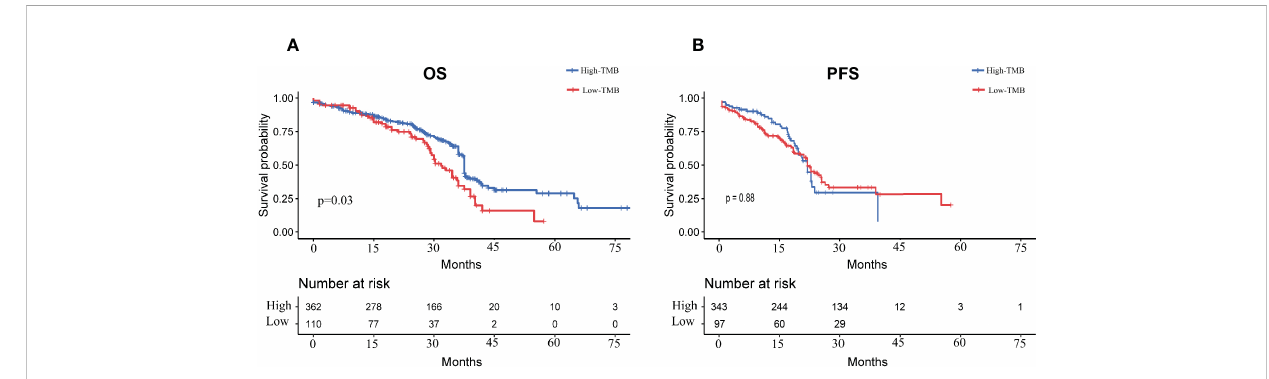
FIGURE 3 Survival curves of LUAD patients in high- and low- TMB groups (A) : OS survival curves of LUAD patients in high and low TMB groups; (B) : PFS survival curves of LUAD patients in high and low TMB